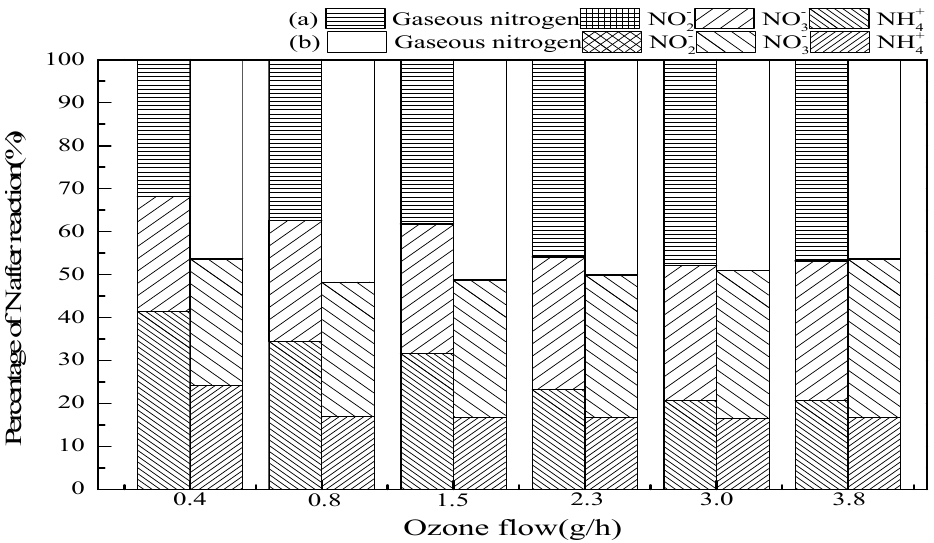
Figure 6. The e ff ect of ozone flow on ammonia conversion. Reaction conditions: initial NH 4 + Figure 6. The effect of ozone flow on ammonia conversion. Reaction conditions: initial NH 4+ concentration 50 mg / L, initial pH 9.5, ozone flow from 0.4 to 3.8 g / h, catalytic dosage 2.0 g / L, temperature concentration 50 mg/L, initial pH 9.5, ozone flow from 0.4 to 3.8 g/h, catalytic dosage 2.0 g/L, 25 ◦ C, reaction time 60 min, ultrasonic frequency 25 kHz, ultrasonic power 270 W, ultrasonic operation temperature 25 °C, reaction time 60 min, ultrasonic frequency 25 kHz, ultrasonic power 270 W, 1 s and interval 2 s. ( a ) SrO-Al 2 O 3 / O 3 , ( b ) SrO-Al 2 O 3 / US / O ultrasonic operation 1 s and interval 2 s. ( a ) SrO-Al 2 O 3 /O 3 , ( b ) SrO-Al 2 O 3 /US/O 3.